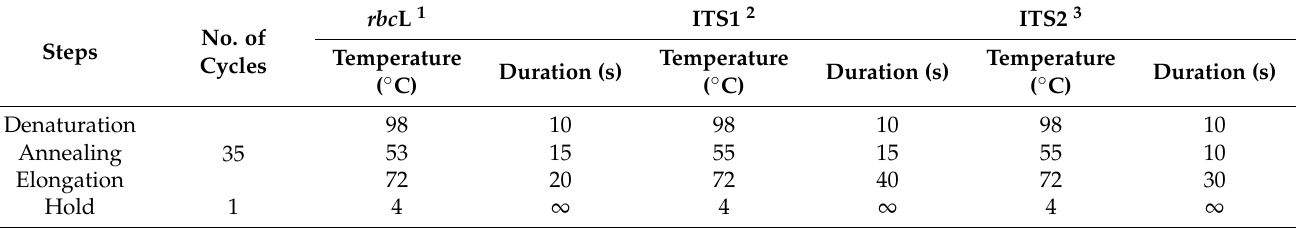
Table 2. List of primers used in this